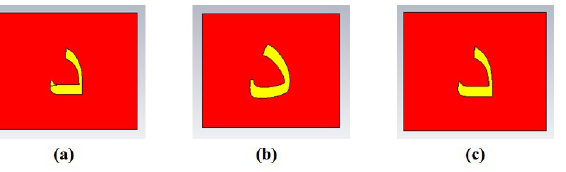
Figure 9. Designed letter (cid:88) tag with various fonts with the same size of 28: ( a ) Arial; ( b ) Calibri; ( c ) Times New Roman (TNR).